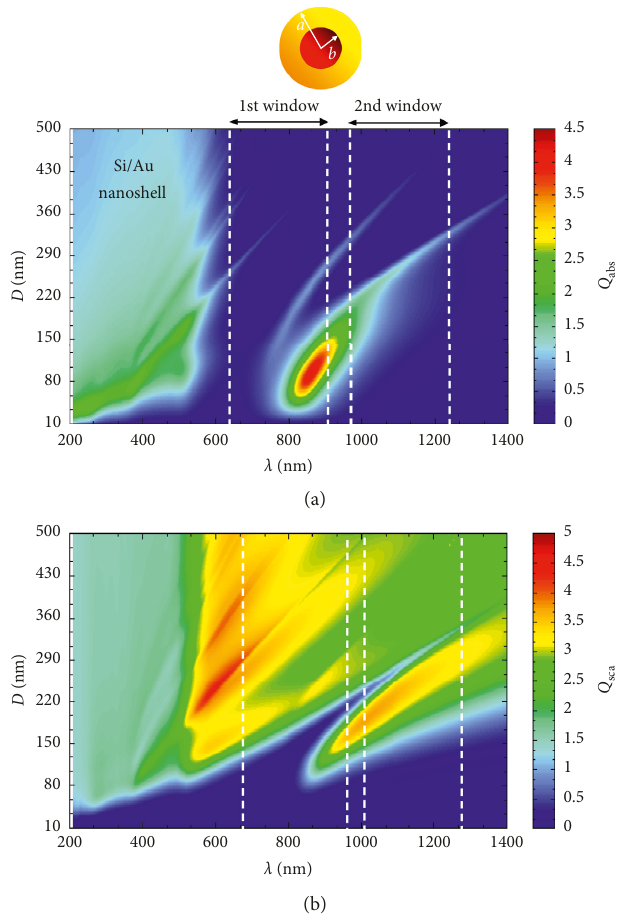
Figure 3: The absorption efficiency Q abs (a) and scattering efficiency Q sca (b) of a single Si/Au nanoshell in biological tissues as a function of the diameter D and the incident light wavelength λ . The vertical dashed lines delimit the optical windows of biological